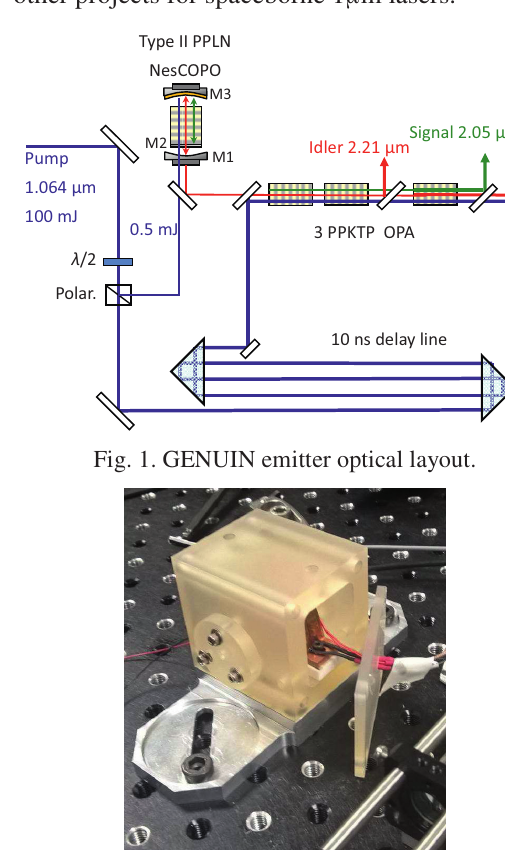
Fig. 2. GENUIN NesCOPO picture.